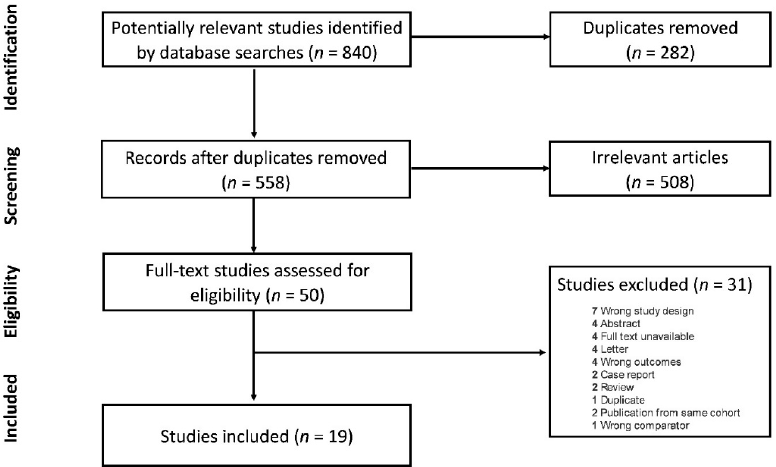
Figure 1. Flow chart of included studies. Table 1. Characteristics of the porphyria study